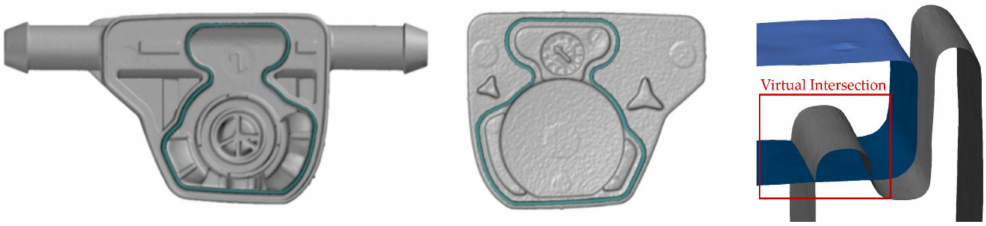
Figure 6. Use case assembly of housing ( left ) and cover ( middle ). Virtual intersection in the welding bead ( right ).